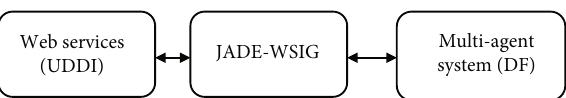
Figure 12: Framework of